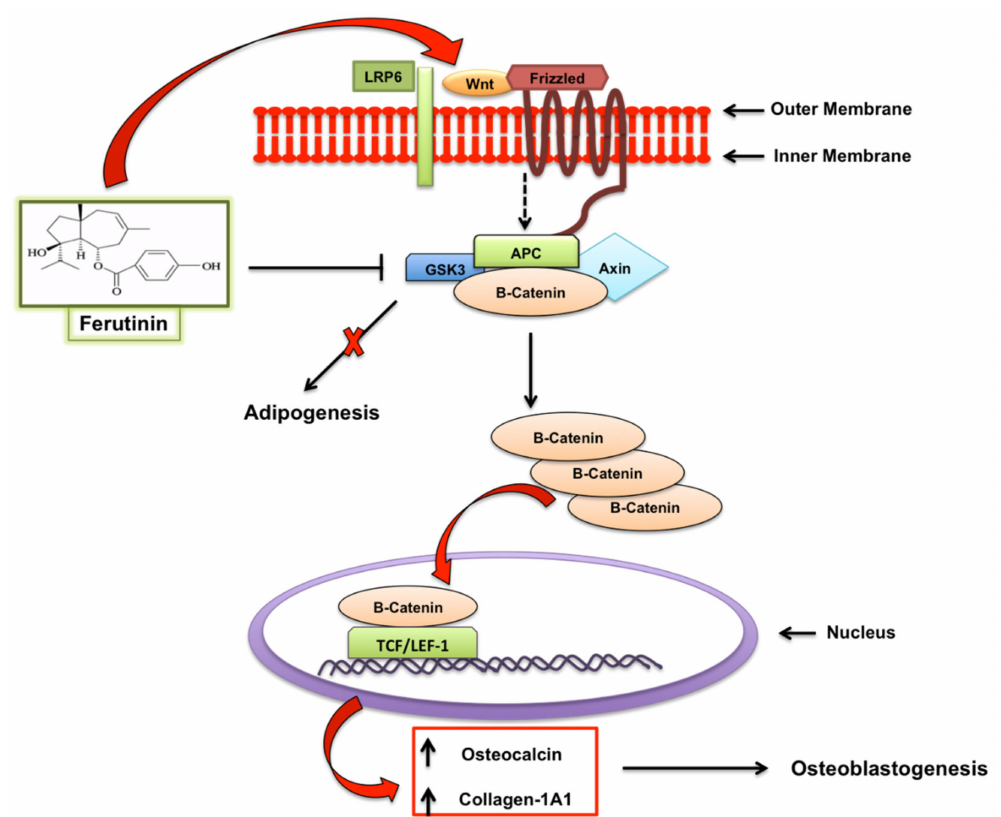
Figure 2. Regulation of Wnt / β catenin pathway by ferutinin: ferutinin induces osteogenic di ff erentiation of dental pulp-derived stem cells and leads to the promotion of